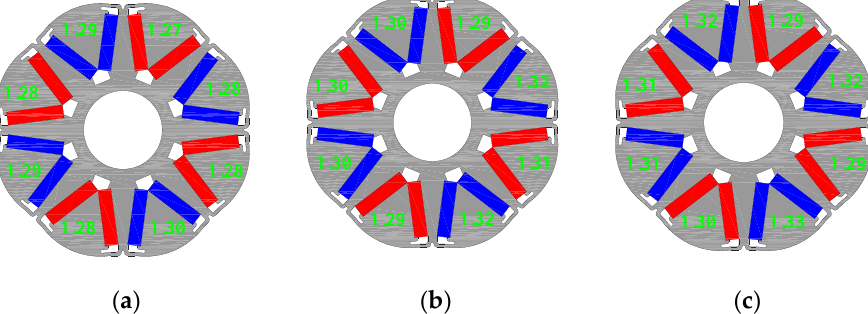
Figure 8. Allocation of the unbalanced remanent flux density in the rotor-skew prototype: ( a ) 1st step; ( b ) 2nd step; and ( c ) 3rd step.